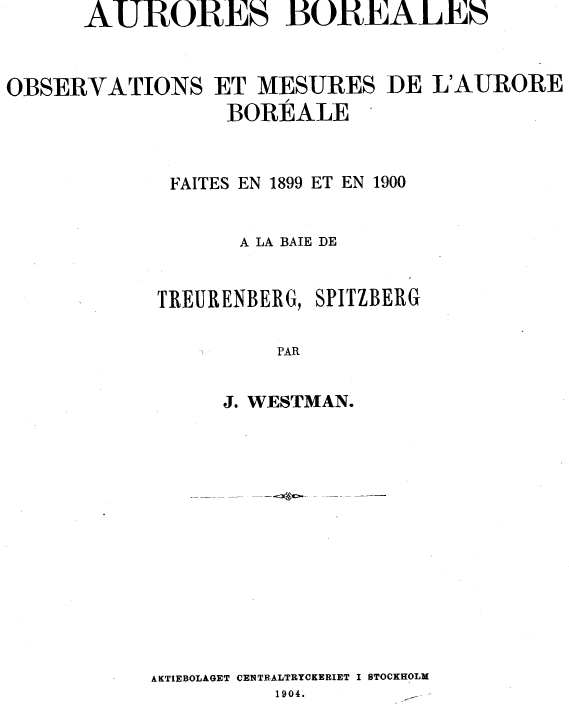
Fig. 5b. Cover page of the report by Westman (1904).